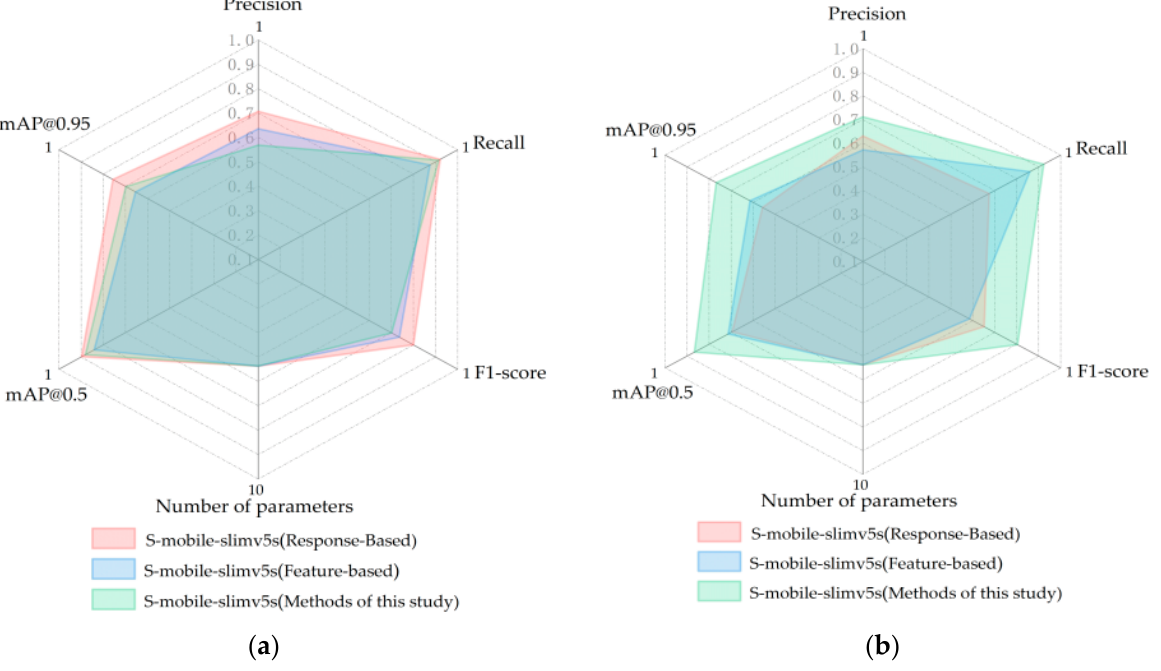
Figure 13. Performance of three knowledge distillation methods. Input data as ( a ) Dataset (T) and ( b ) Dataset (S).